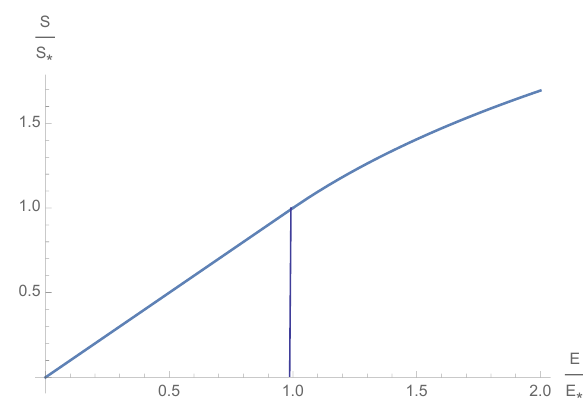
Figure 3 . Entropy versus Energy. The plot has a continuous phase transition at E (cid:3) , where the slope is continuous but there are non trivial critical exponents at E (cid:3) on the right hand